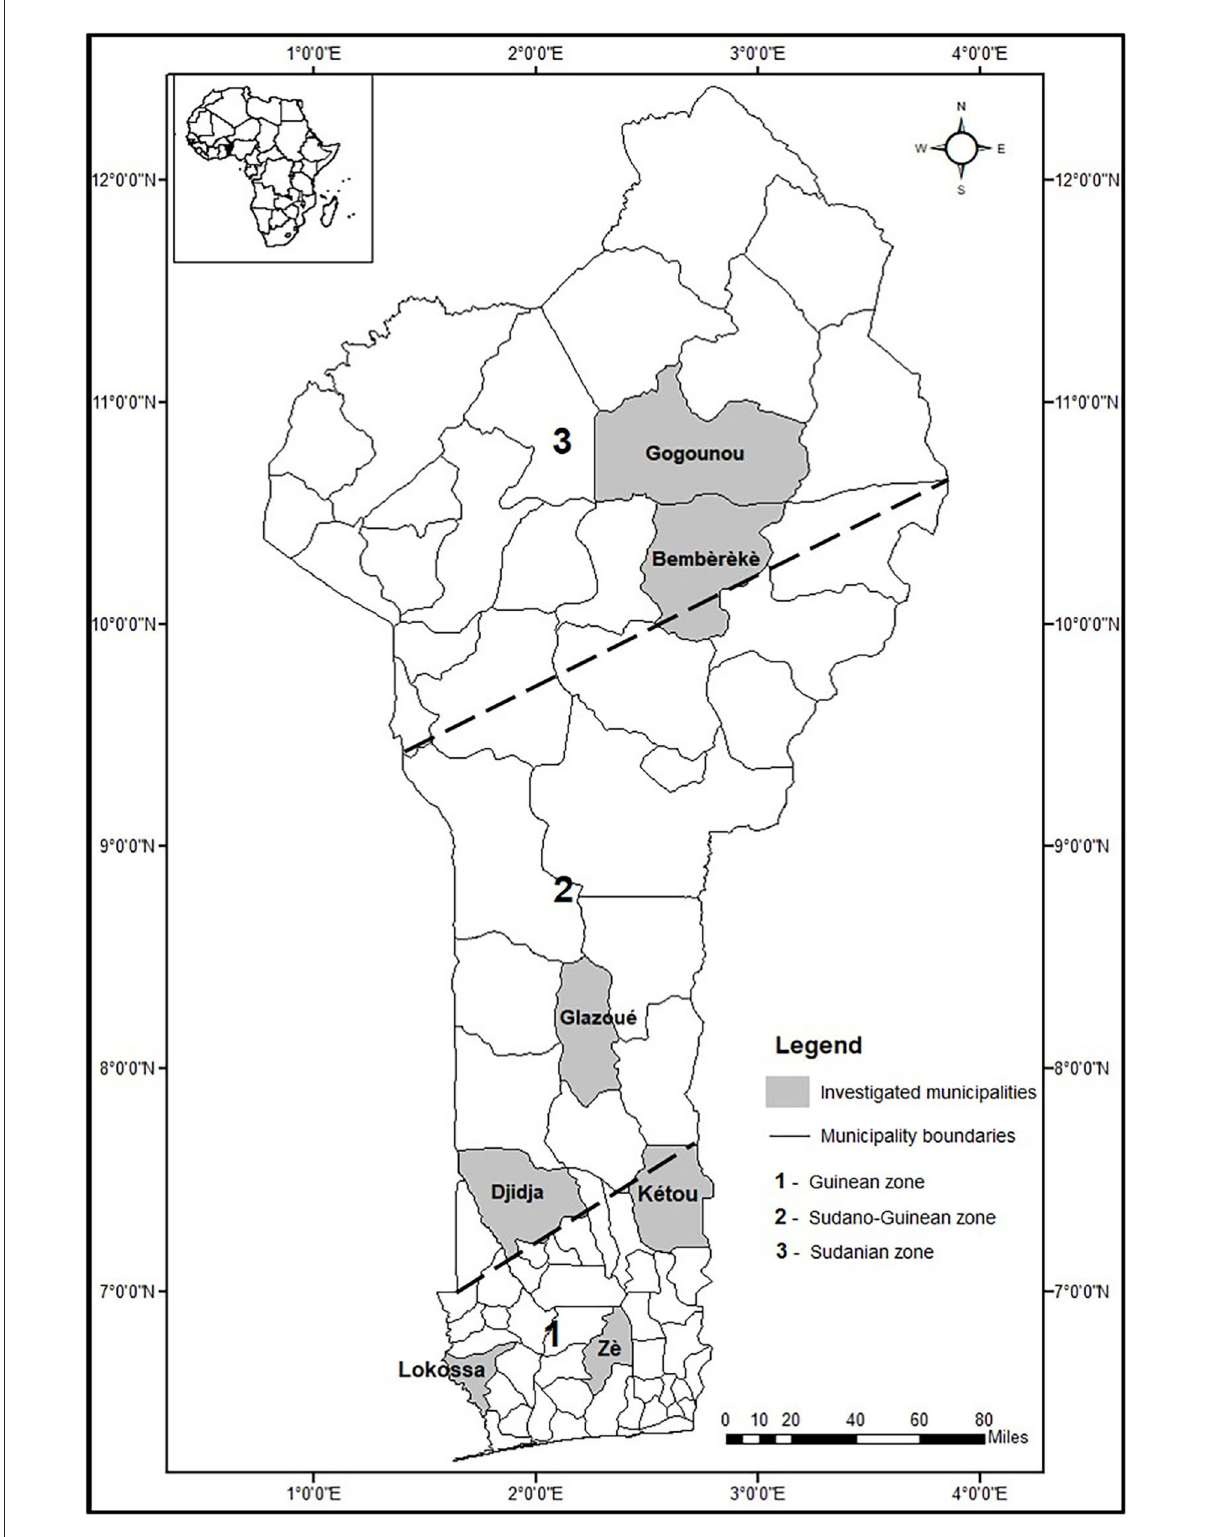
FIGURE1 Location of the study